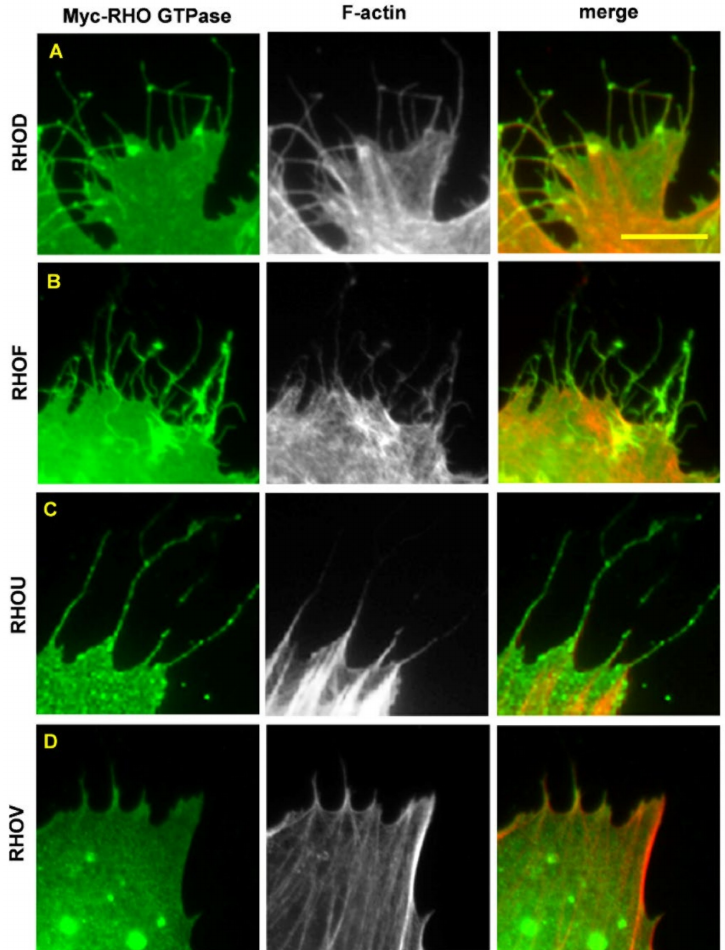
Figure 1. Atypical fast-cycling RHO GTPases trigger the formation of filopodia in fibroblasts. Human BJ/SV40T fibroblasts were transfected with Myc-RHOD ( A ), Myc-RHOF ( B ), Myc-RHOU ( C ), or Myc-RHOV ( D ). A non-transfected control is shown in Figure 2D for comparison. The Myc-tagged RHO GTPases were visualized using a mouse anti-Myc antibody, followed by an AlexaFluor 488- conjugated anti-mouse antibody. Filamentous actin was visualized with TRITC-conjugated phalloidin. Scale bar, 10 µ